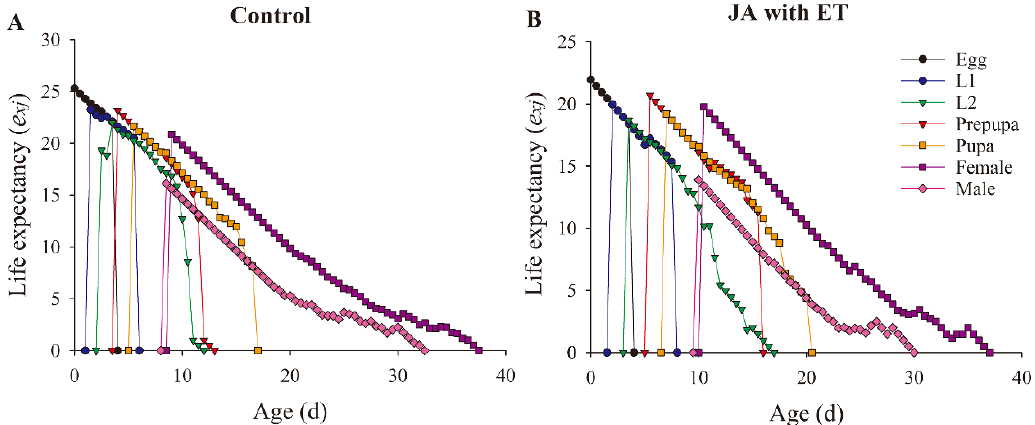
Figure 8. Effect of the JA with ET treatment on the age-stage-specific life expectancy ( e xj ) of Frankliniella occidentalis grown on faba bean plants. ( A ) Control group; ( B ) JA with ET group.